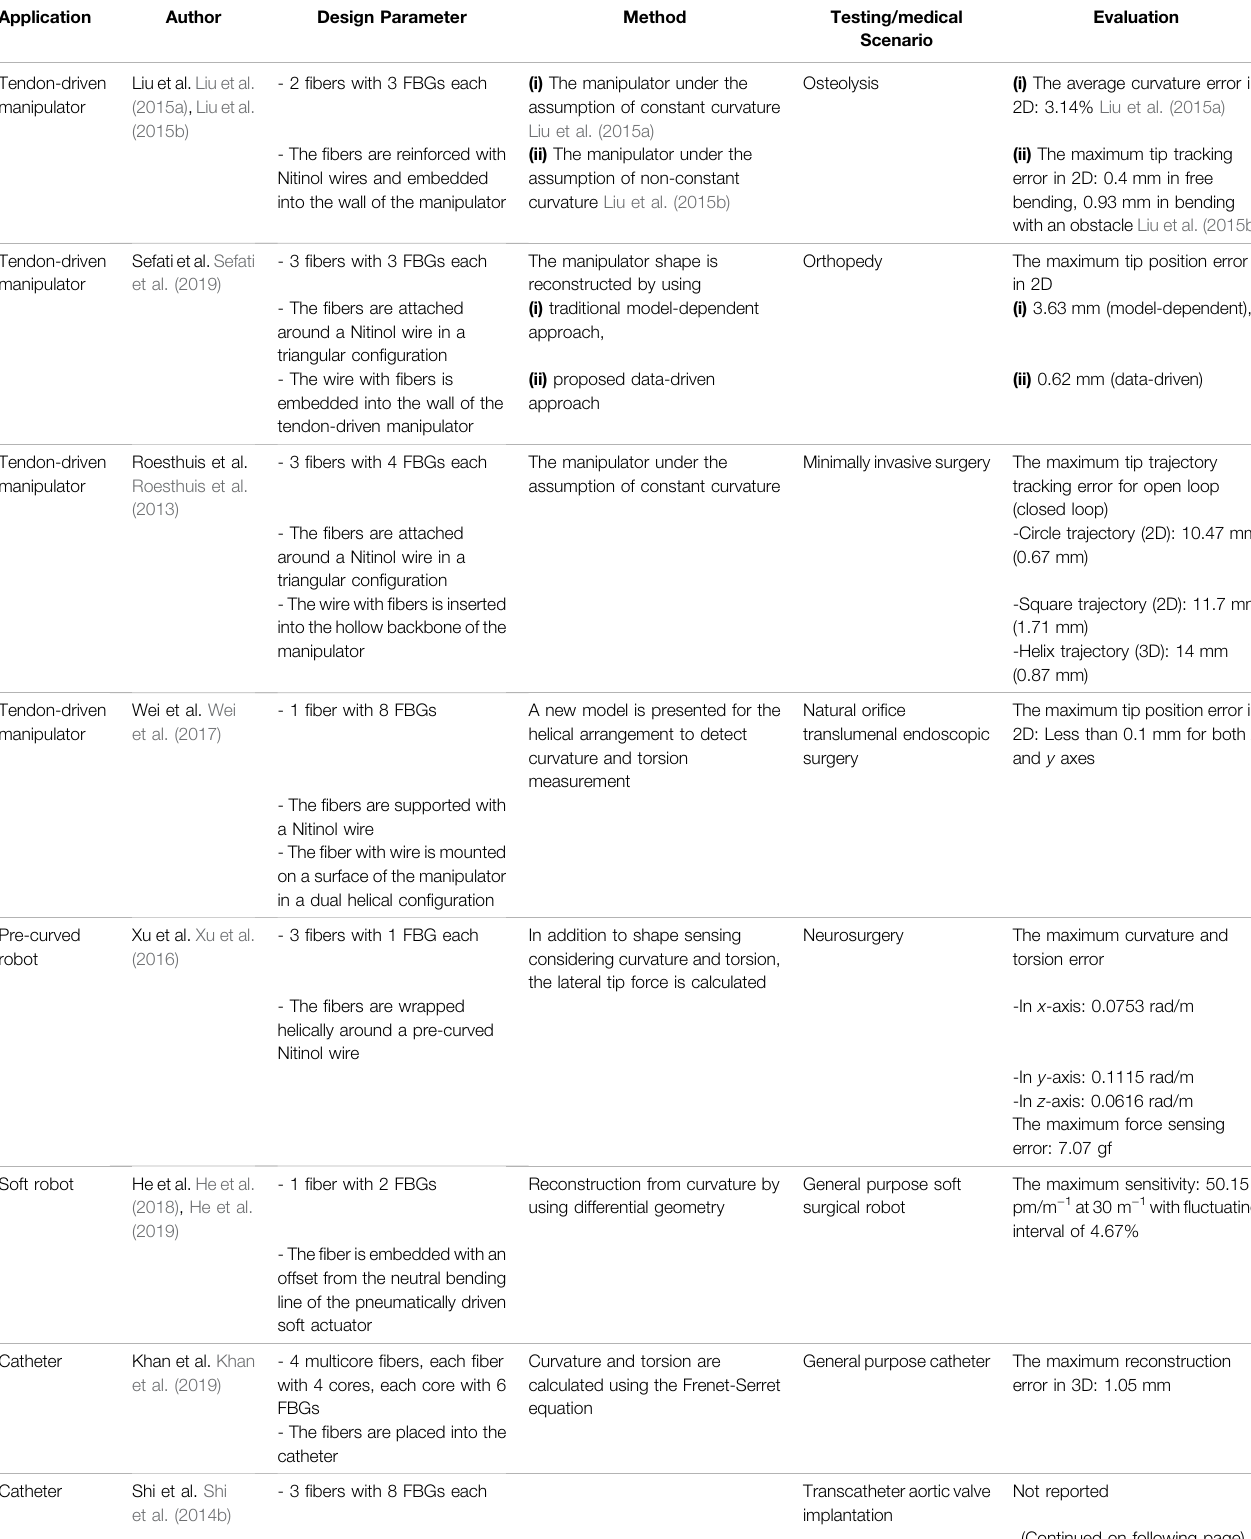
TABLE 1 | Summary of FBG based Shape Reconstruction